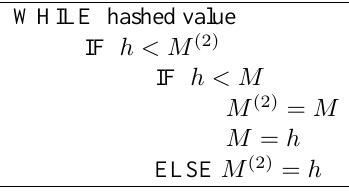
Fig. 1: Internal loop for k = 2